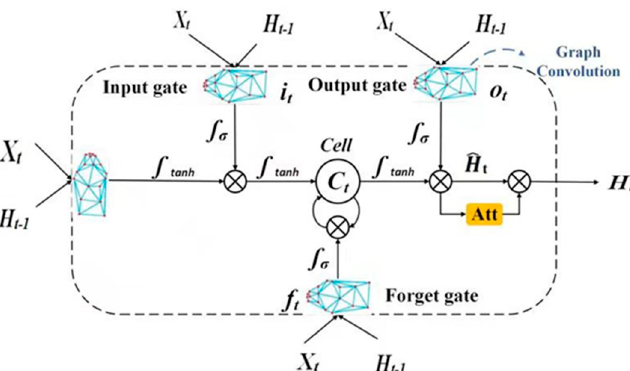
Figure 2. The structure of an ASTGC-LSTM unit. Compared with LSTM, the inner operator of the ASTGC-LSTM is graph convolution. In order to highlight more discriminative information, the attention mechanism is used to enhance the characteristics of key nodes.